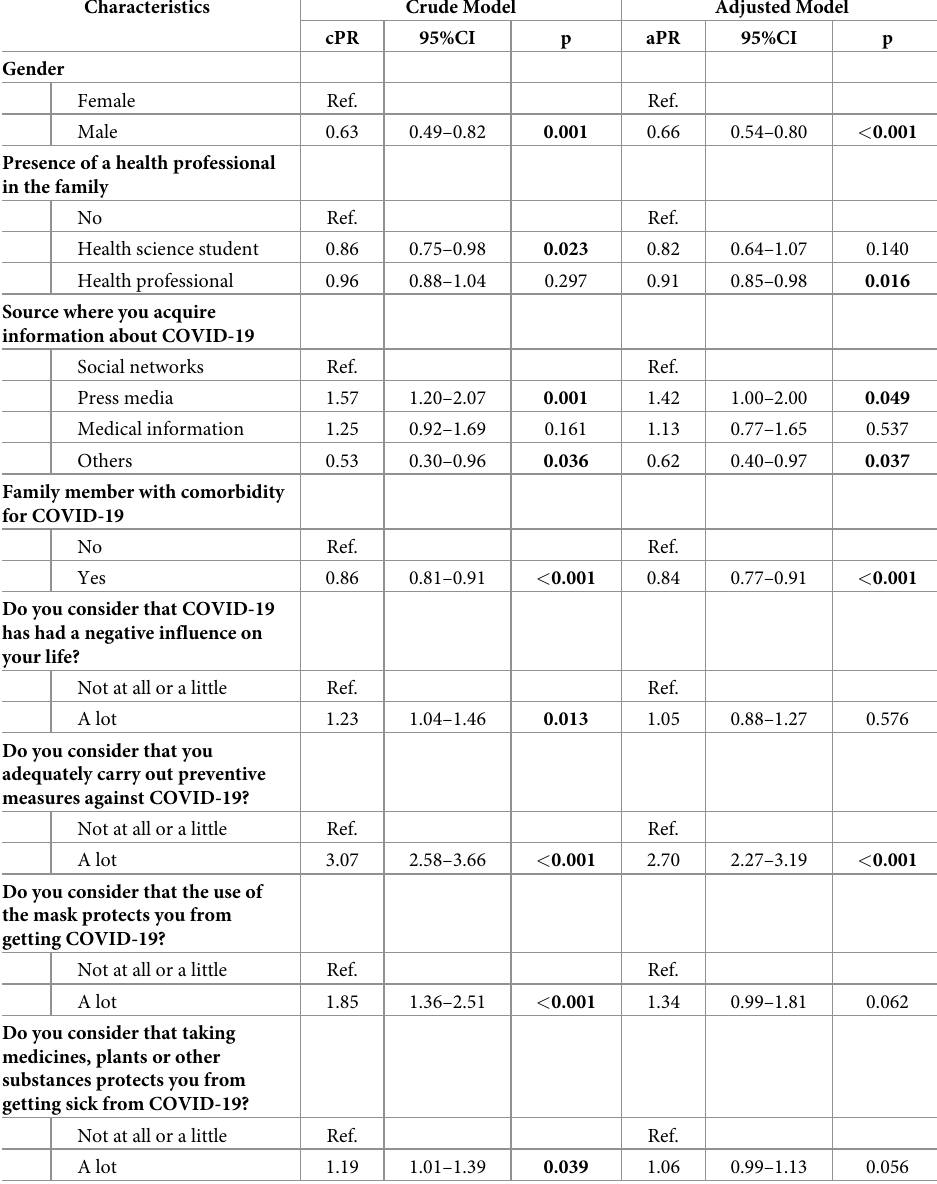
Table 5. Factors associated with prevention practices for COVID-19 infection in rural